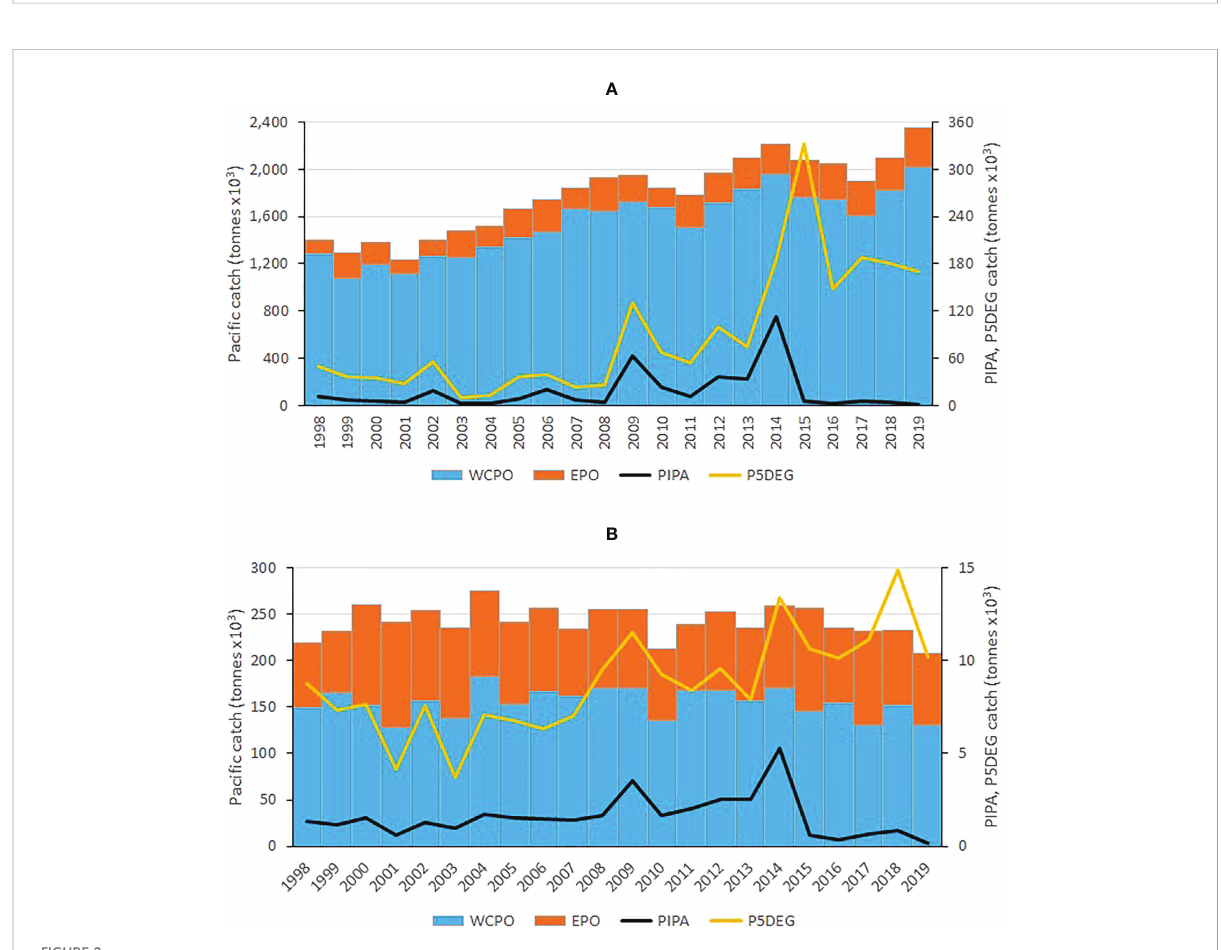
FIGURE 2 Skipjack (A) and bigeye (B) tuna annual catches in the western and central Paci fi c Ocean (WCPO, the Paci fi c Ocean west of 150°W), eastern Paci fi c Ocean (EPO, the Paci fi c Ocean east of 150°W), the Phoenix Islands Protected Area (PIPA) and the fi ve-degree spill-over area surrounding the PIPA (P5DEG). See Figure 1 for the area de fi